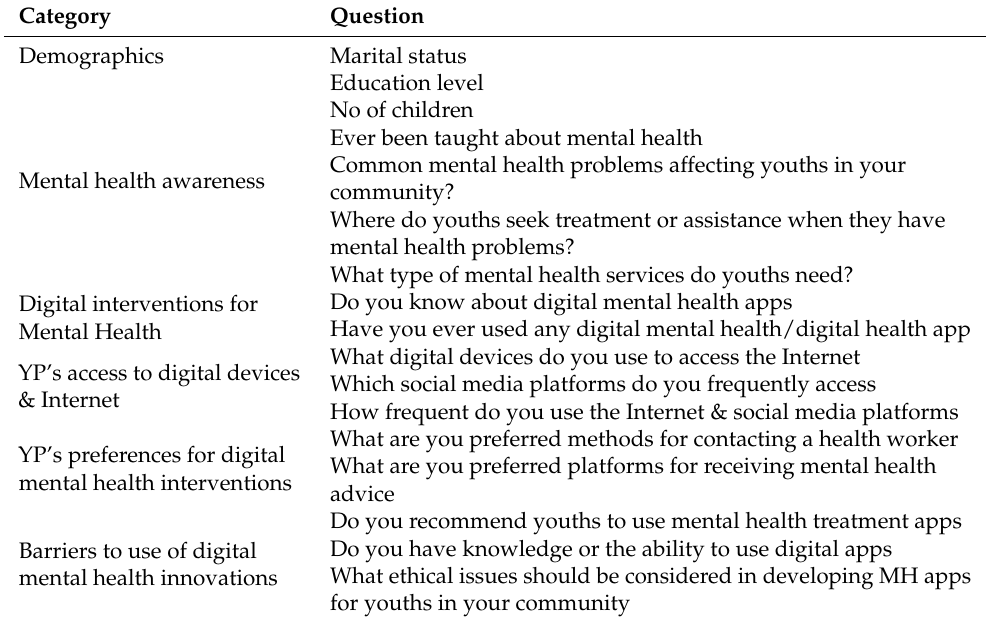
Table 1. Showing the main questions that constituted the questionnaire used for the